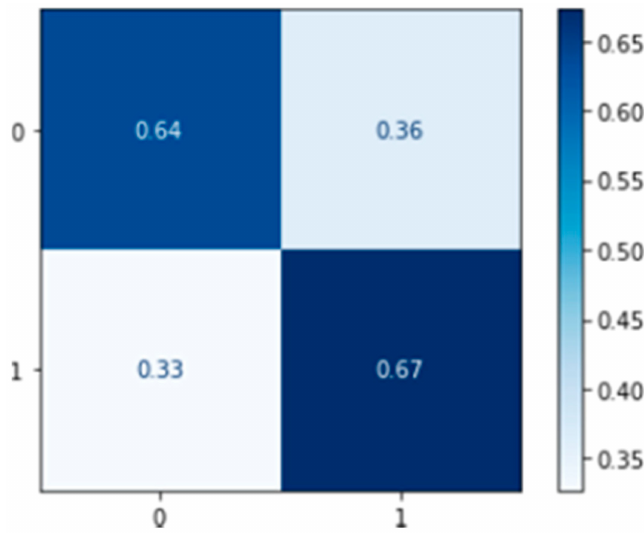
Figure 8. Confusion Matrix of the Logistic Regression.